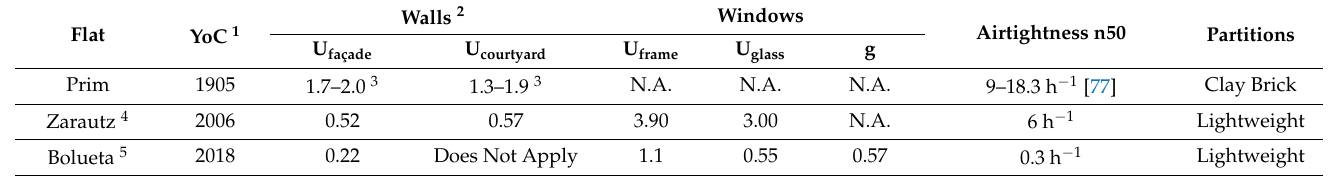
Table 3. Summary of constructive elements’ properties of the analyzed buildings.